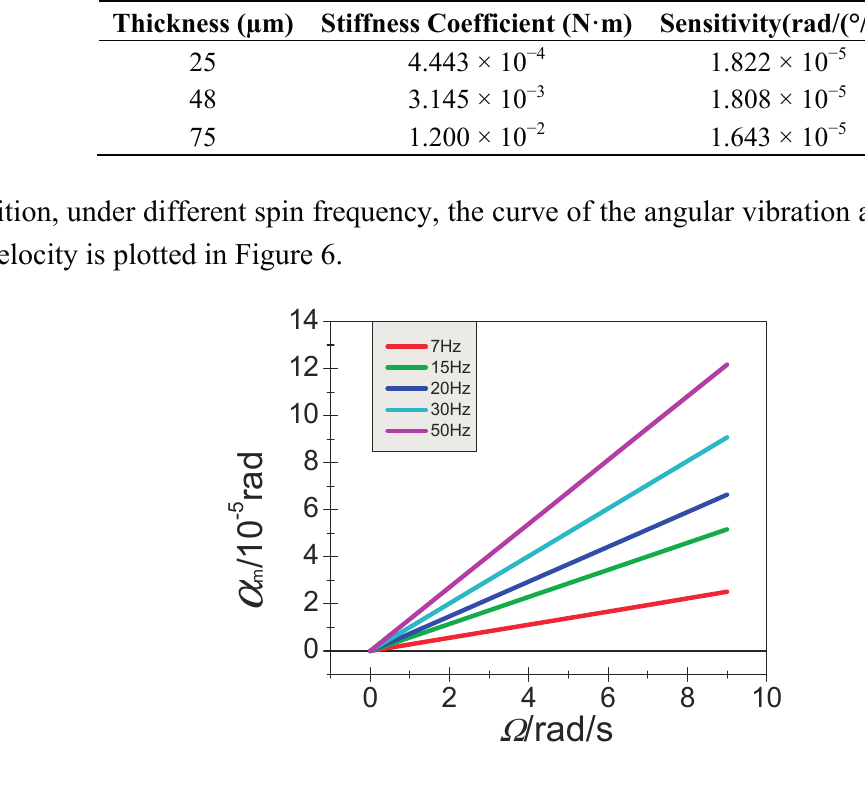
Figure 6. The relation curve between angular vibration amplitude and input angular velocity under different spin